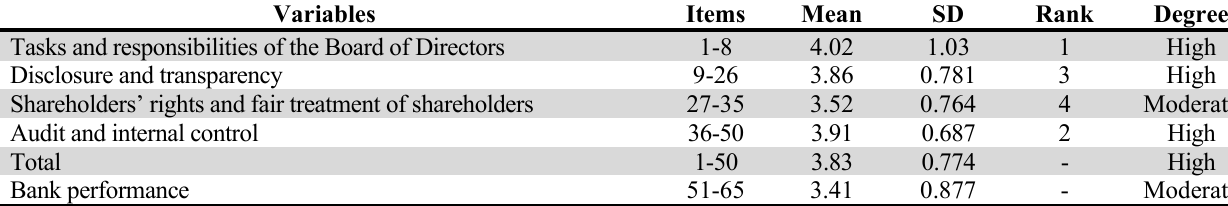
Means and standard deviations of corporate governance and bank performance